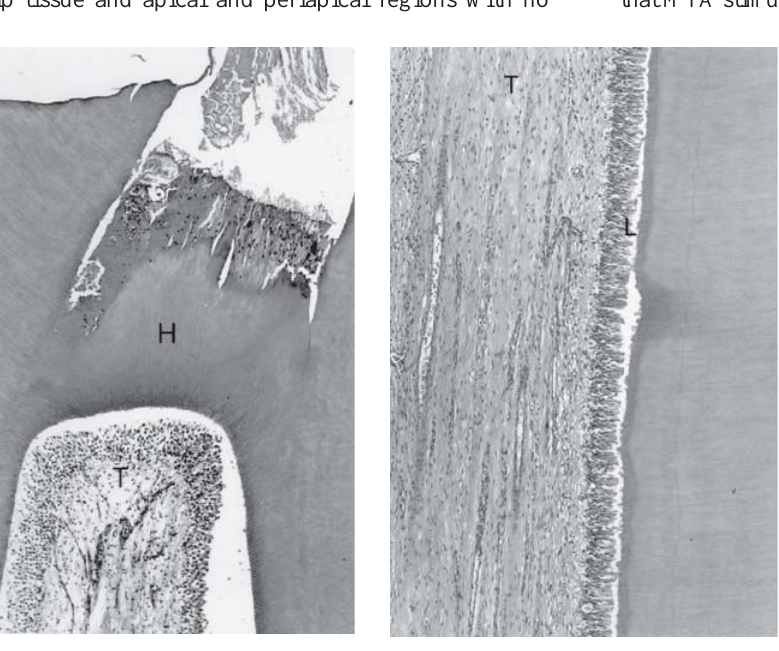
FIGURE 2- Group I (MTA): normal odontoblastic layer (L). Normal connective pulp tissue (T). (hematoxylin and eosin - X 40)